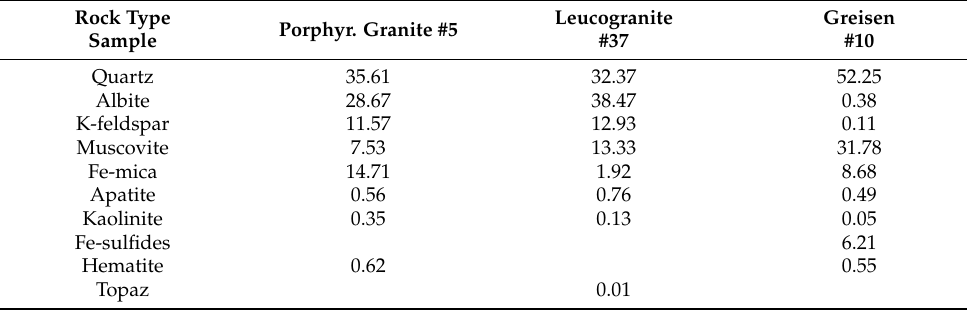
Table 1. Modal composition according to TIMA